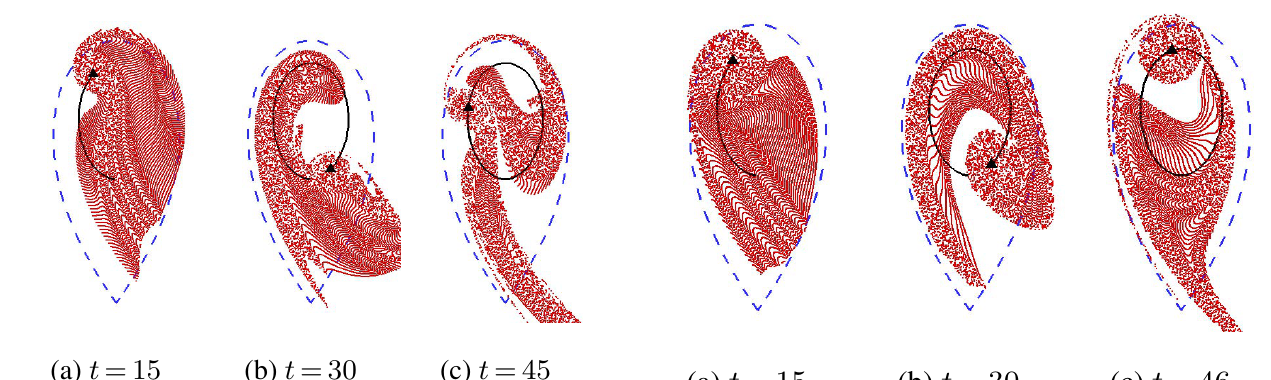
(c) t = 45 Fig. 6: An example of particle scattering in the upper-layer monopole case due to counter-rotation of the monopole and topographic vortex, κ = − 0 . 1 , y 0 = − 3 . 5 . Bold black curve is the trajectory of the monopole, with a triangle that shows